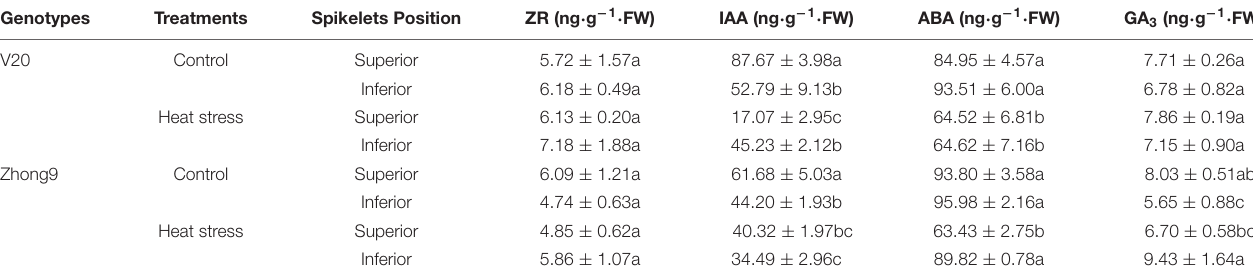
FIGURE 9 | Effect of heat stress on the starch branching enzyme (Q enzyme) activity (A) and soluble sugar content (B) of superior and inferior spikelets at anthesis of rice. SS and IS were indicated as superior spikelets and inferior spikelets, respectively. Vertical bars denote standard deviations ( n = 4). Different letters indicate significant differences in the same cultivar ( P < 0.05).